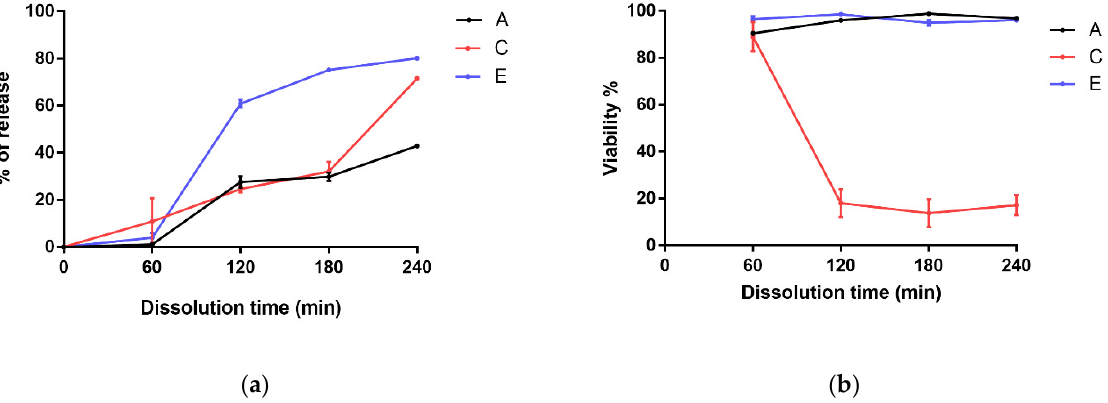
Figure 6. Release of Lactobacillus plantarum from microcapsules ( a ), and viability of released bacteria ( b ). Uncoated alginate (A), chitosan-coated (C), and Eudragit-coated (E) microcapsules were investigated in triplet. Data are presented as means ± SDs, n = 3.